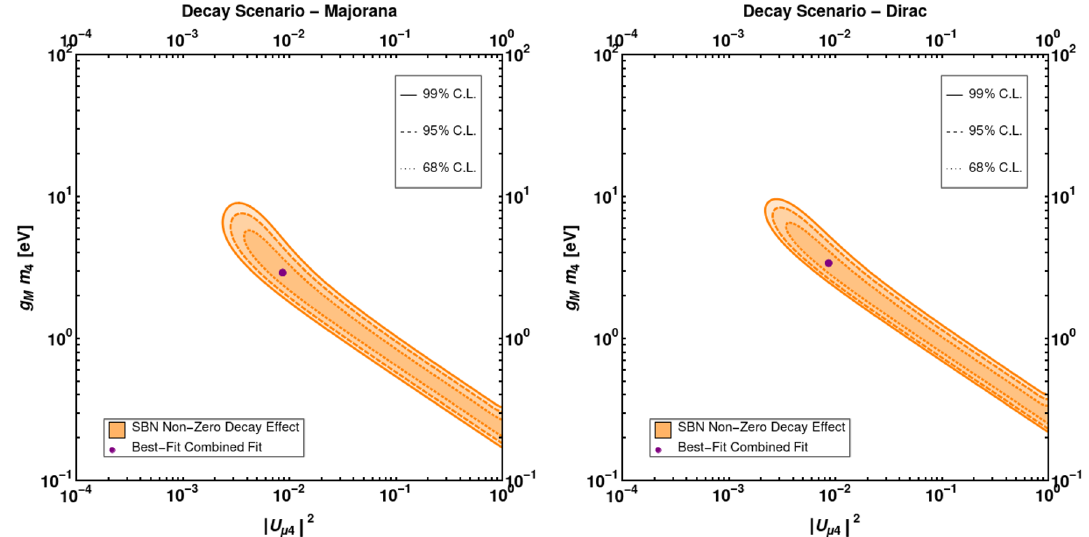
Figure 9 . SBN allowed regions for non-zero decay scenario parameters ( j U (cid:22) 4 j 2 ; gm 4 ) at 99% (solid line), 95% (dashed line) and 68% (dotted line) C.L. for Majorana (left) and Dirac neutrinos (right). The dots indicate the best-(cid:12)t-point from the LSND, MiniBooNE, KARMEN and MINOS